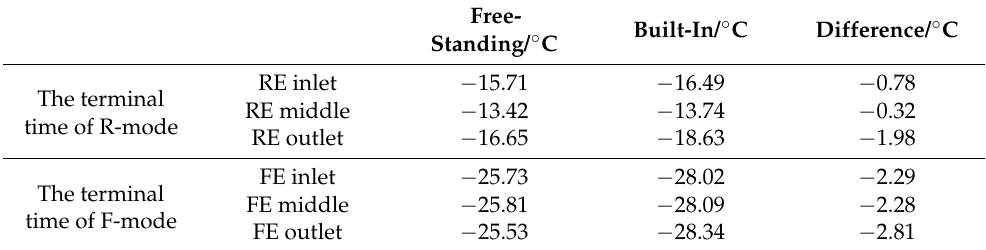
Figure 9. Comparison of the power and evaporating temperature during on/off cycle. Table 7. Comparison of evaporating temperature on the termination of R and F mode.